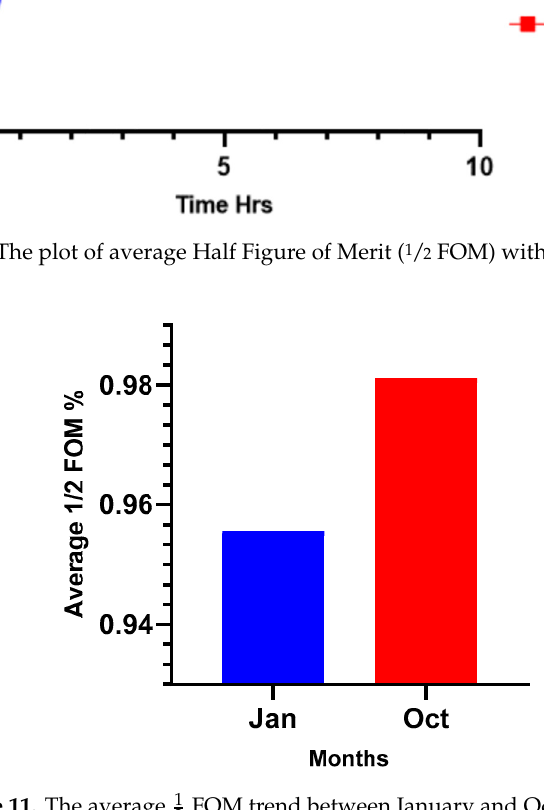
Figure 11. The average ½ FOM trend between January and October 2019.